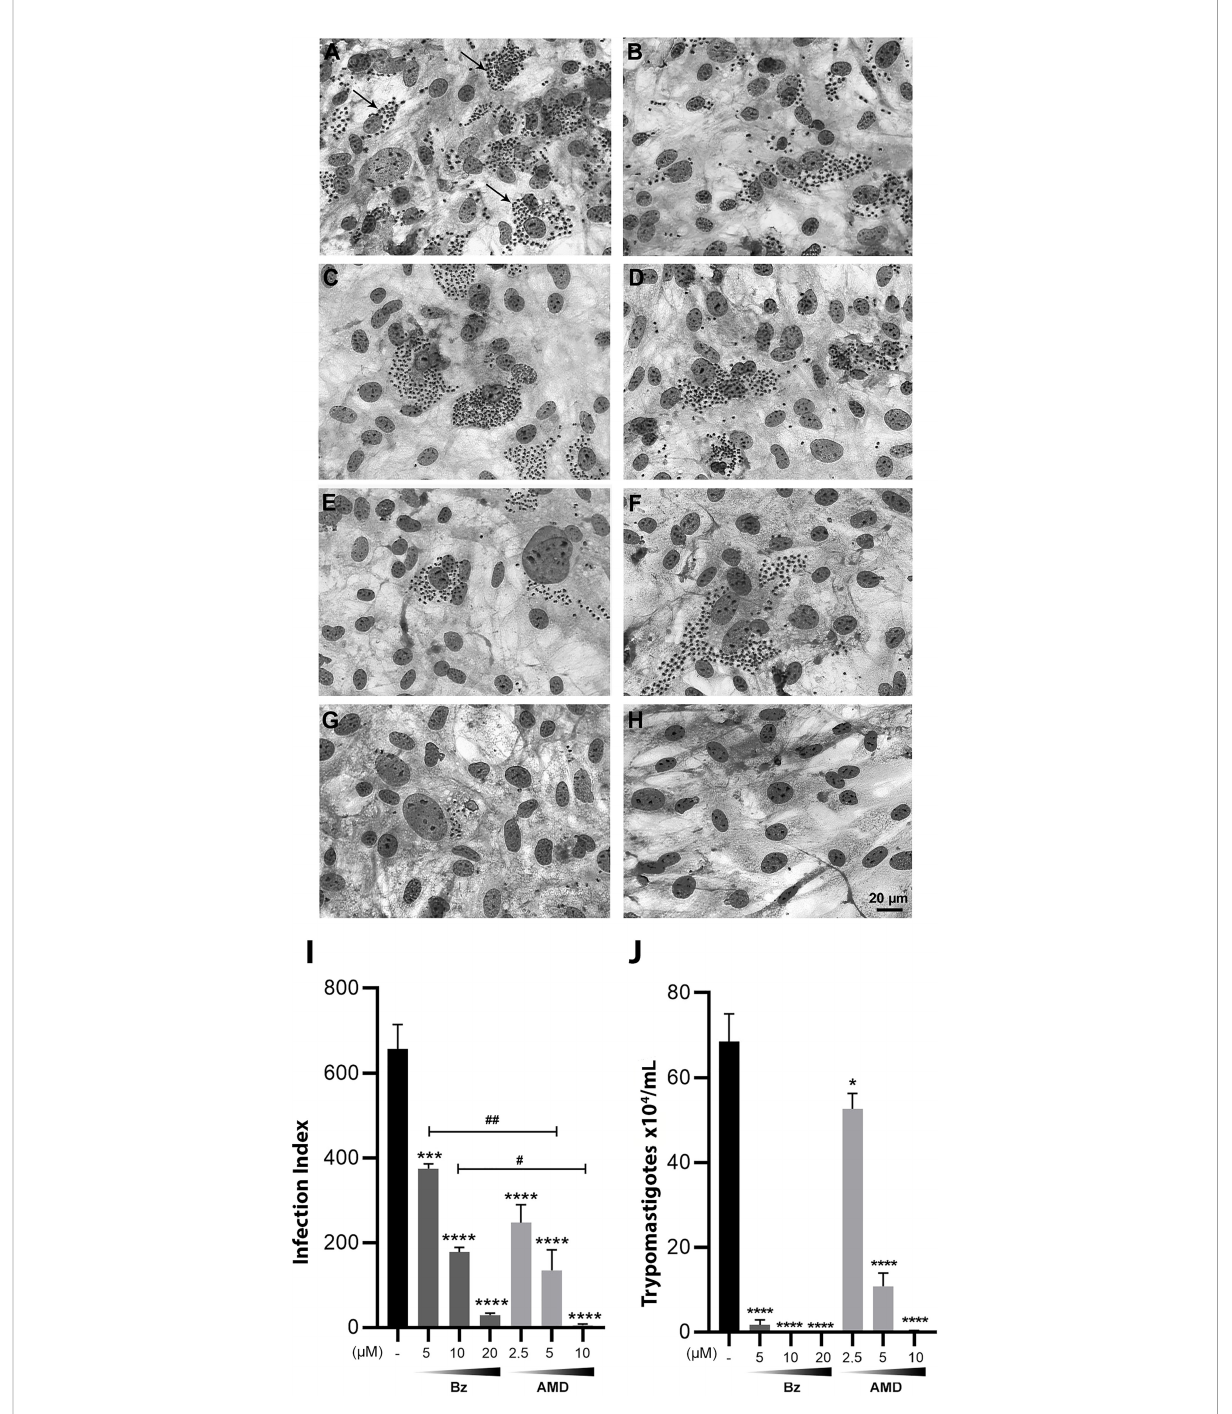
FIGURE 5 Trypanocidal effect of Bz and AMD in monotreatment on intracellular forms of T. cruzi -infected HCs, after 72 h of treatment, evidencing that AMD was more effective in eliminating intracellular parasites than Bz. Representative photomicrograph of infected HCs fi xed and stained with Diff-Quick Staining: (A, B) Untreated cells ( Tc ); Cells treated with (C) 5 µM Bz; (E) 10 µM Bz; (G) 20 µM Bz; (D) 2.5 µM AMD; (F) 5 µM AMD; (H) 10 µM AMD; (I) infection index and (J) number of trypomastigotes in the supernatants. The black bar corresponds to the control condition (infected and untreated; dark and light gray bars correspond to Bz and AMD, respectively). Black arrows indicate intracellular parasites. All concentrations were compared to the control. p range: * # : p < 0.05; ## : p < 0.01; ***: p < 0.001; ****: p < 0.0001. (One-way ANOVA followed by Tukey ’ s post-hoc